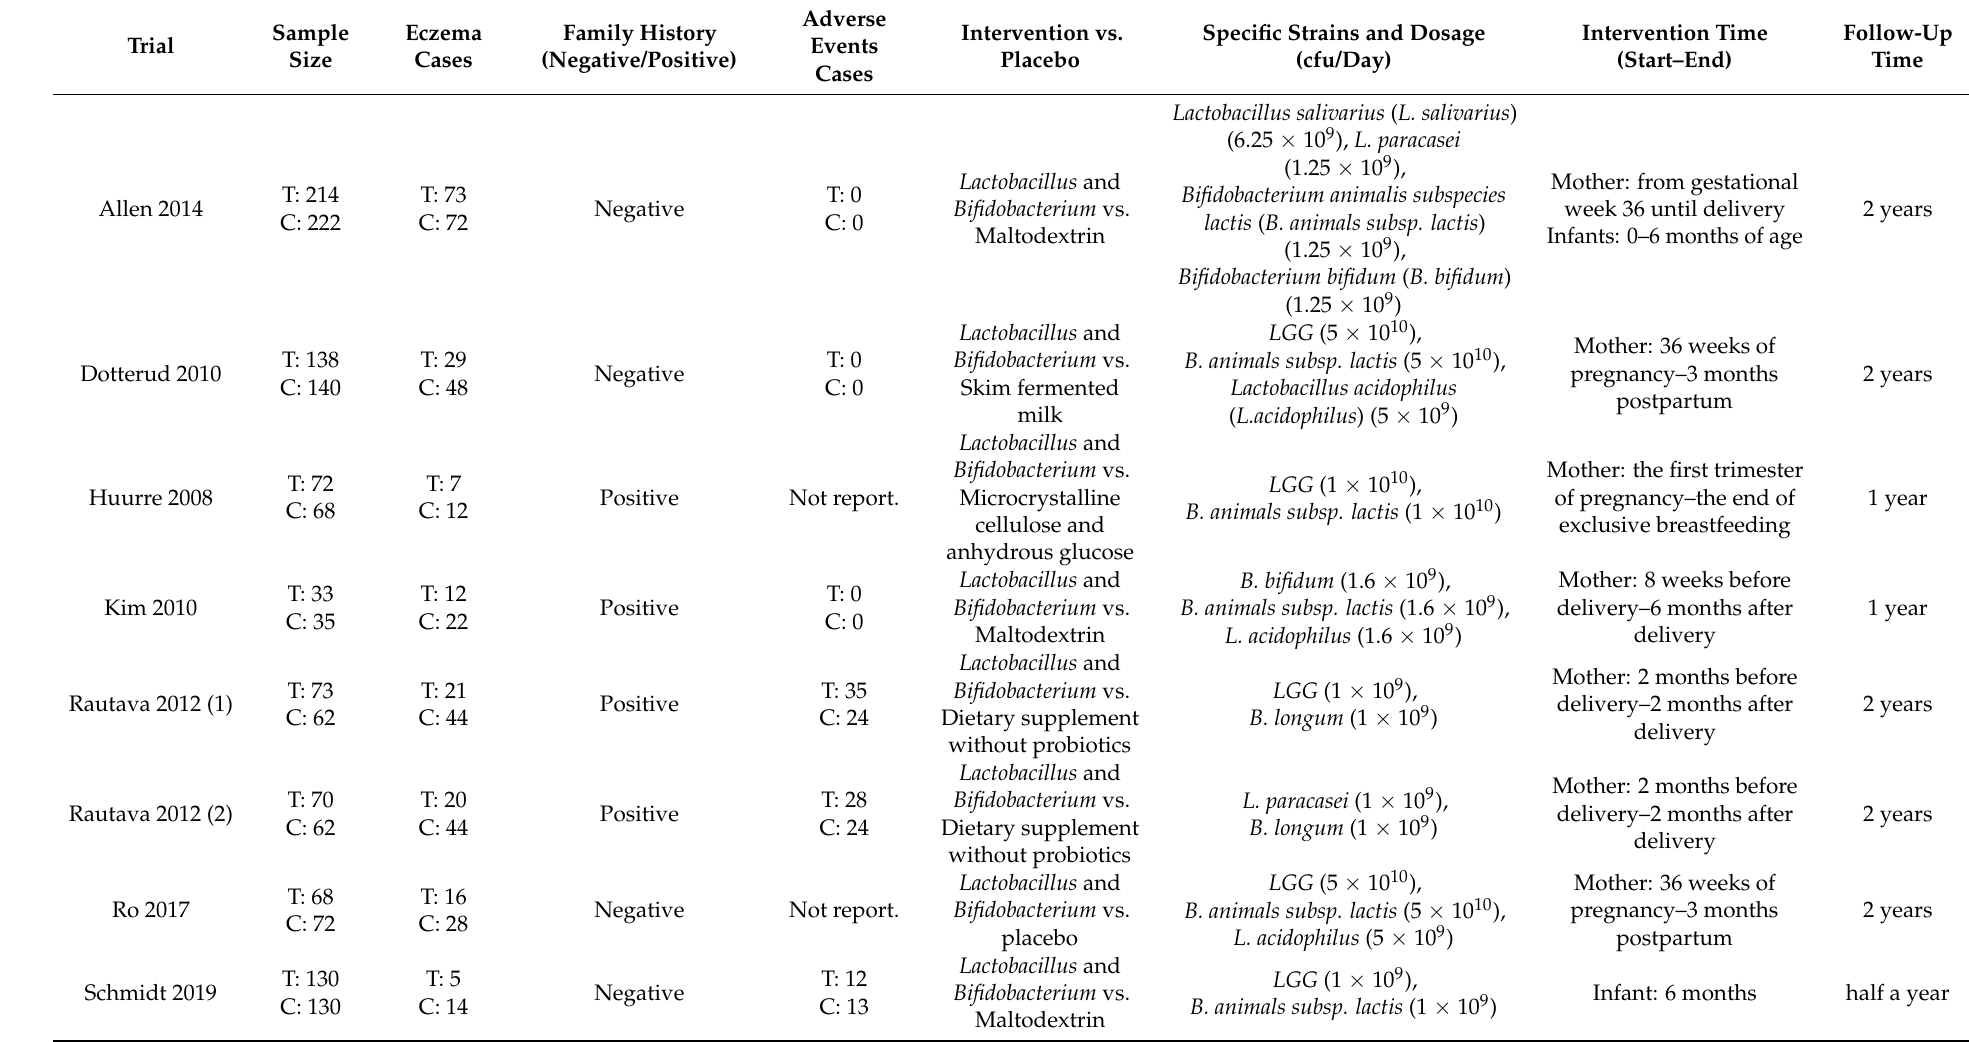
Table 1. Characteristics of the included